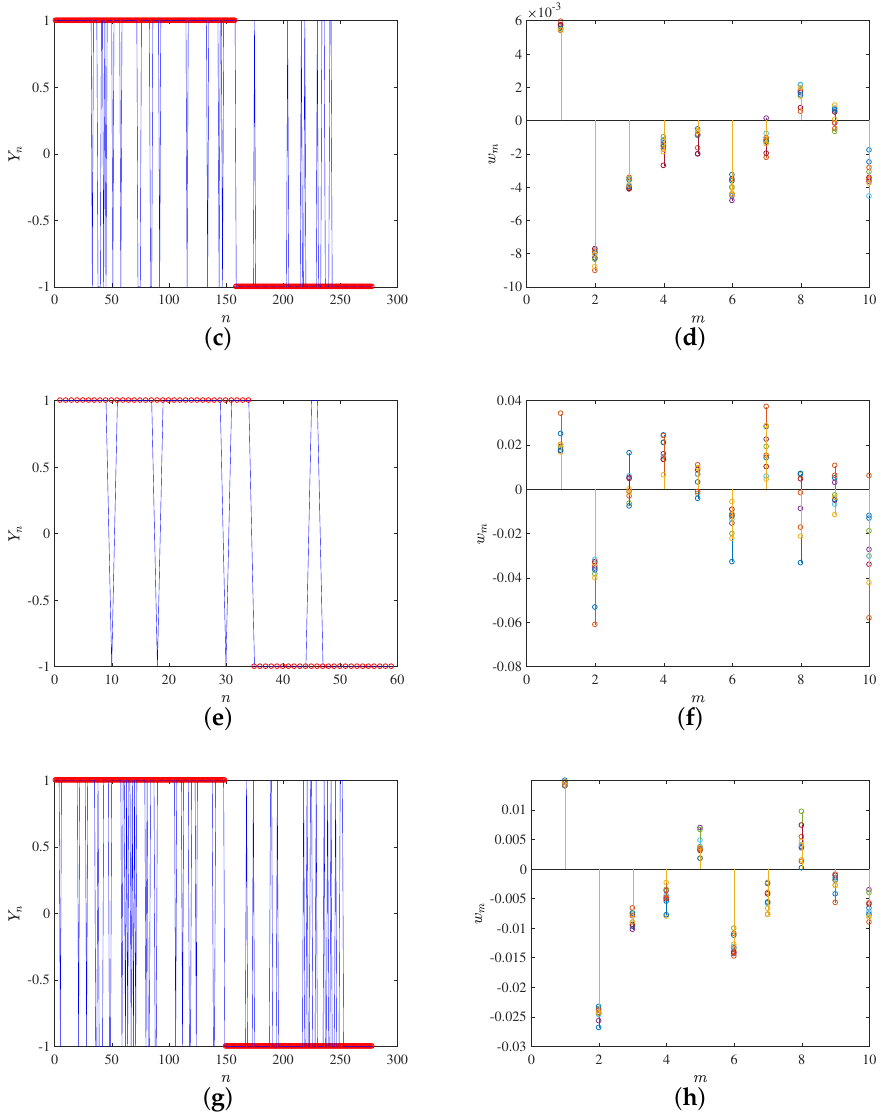
Figure 6. Classification results for FLD ( a – d ) and SVM ( e – h ), for high-confidence contact ( a , b and e , f ) and likely contact ( c , d and g , h ) groups. Left panels show target classification (red points) and machine-provided classification (in blue). Right panels depict the vector weights for the classifiers and for the 10